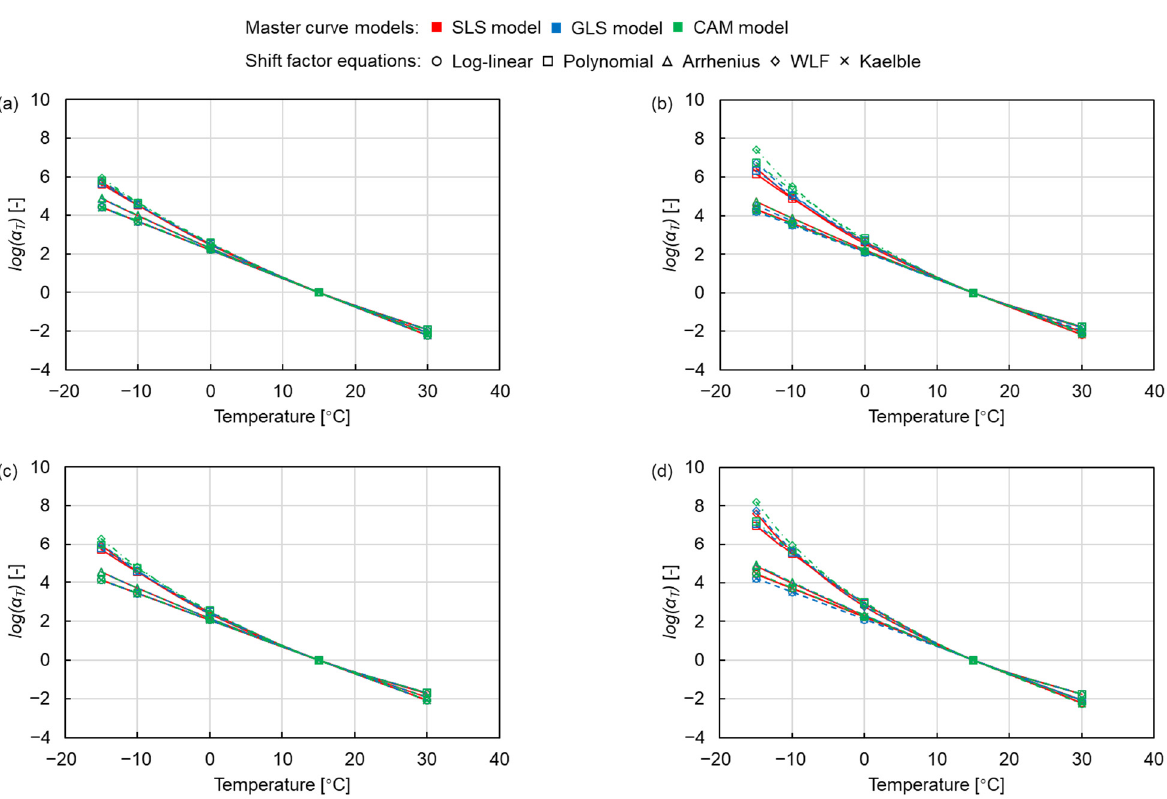
Figure 6. Shift factors of ( a ) AC 11-NB, ( b ) AC 11-PMB, ( c ) SMA 11-NB and ( d ) SMA 11-PMB.